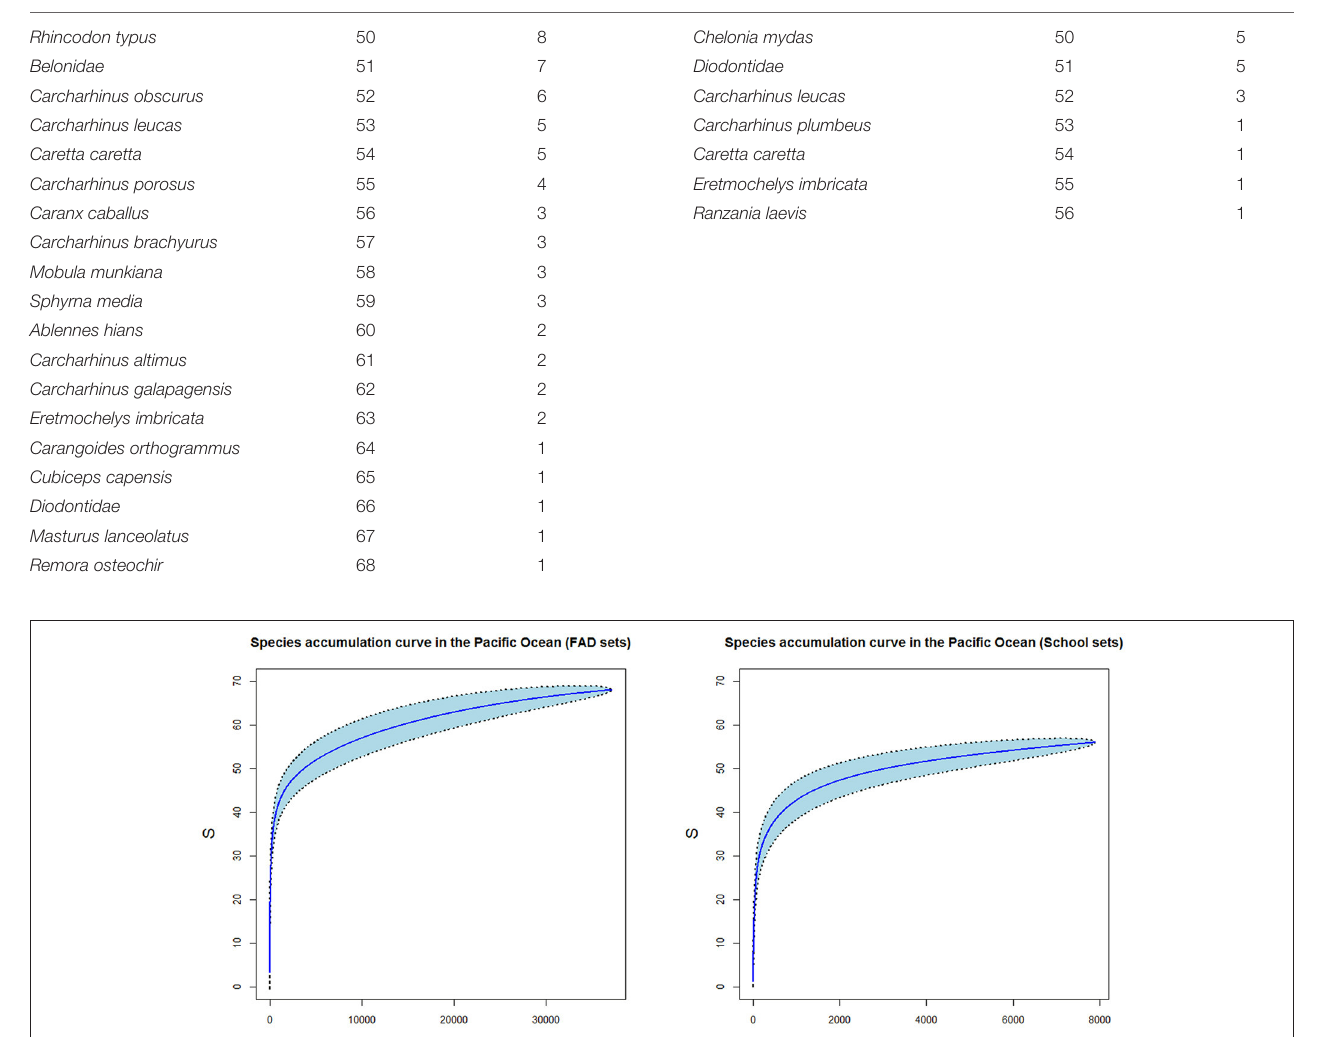
chlorophyll and current